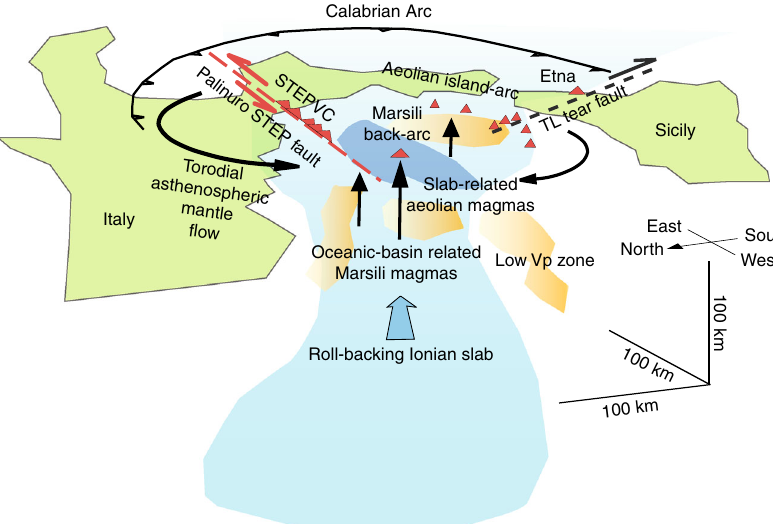
Fig. 10 Conceptual geodynamic model of the Palinuro STEP volcanism. The location and extent of the STEP volcanic chain are from Fig. 2. The black arrows represent the zone of mantle upwelling from asthenospheric (Marsili back-arc, rear of the Ionian slab) or lithospheric (Aeolian Islands) sources according to geophysical 14, 15, 20 – 22 and geochemical data 50 . The toroidal mantle fl ow trajectories are from the geophysical data of ref. 25 . The velocity anomalies are identi fi ed according to refs. 14 – 23 and the Ionian slab is imaged on the basis of the earthquakes of Fig.